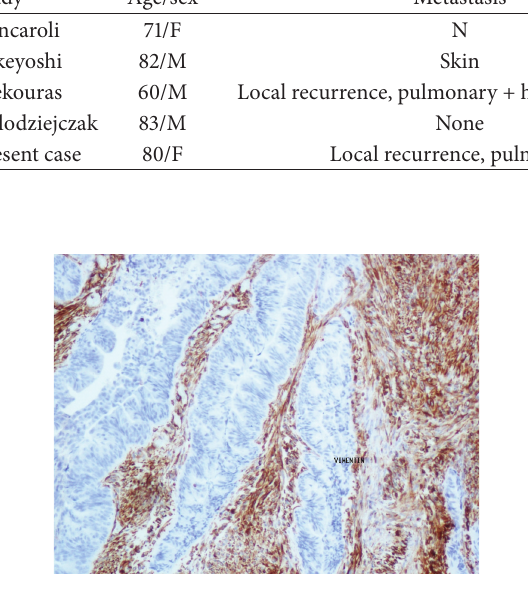
Figure 7: Positive staining for vimentin in the sarcomatous compo-